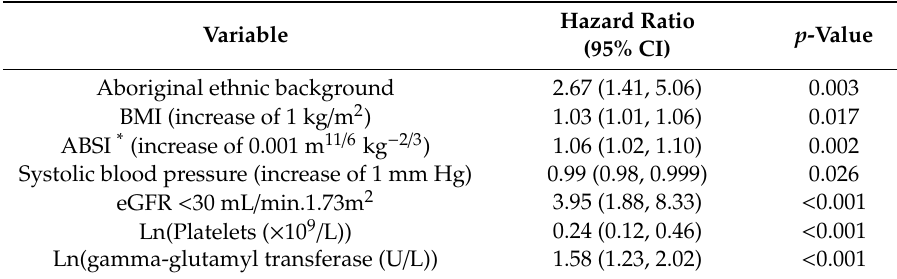
Table 5. Cox regression model of independent associates of new-onset incident hepatobiliary disease in participants with type 2 diabetes in the Fremantle Diabetes Study Phase II who had no prior history of hepatobiliary disease, using age as the time